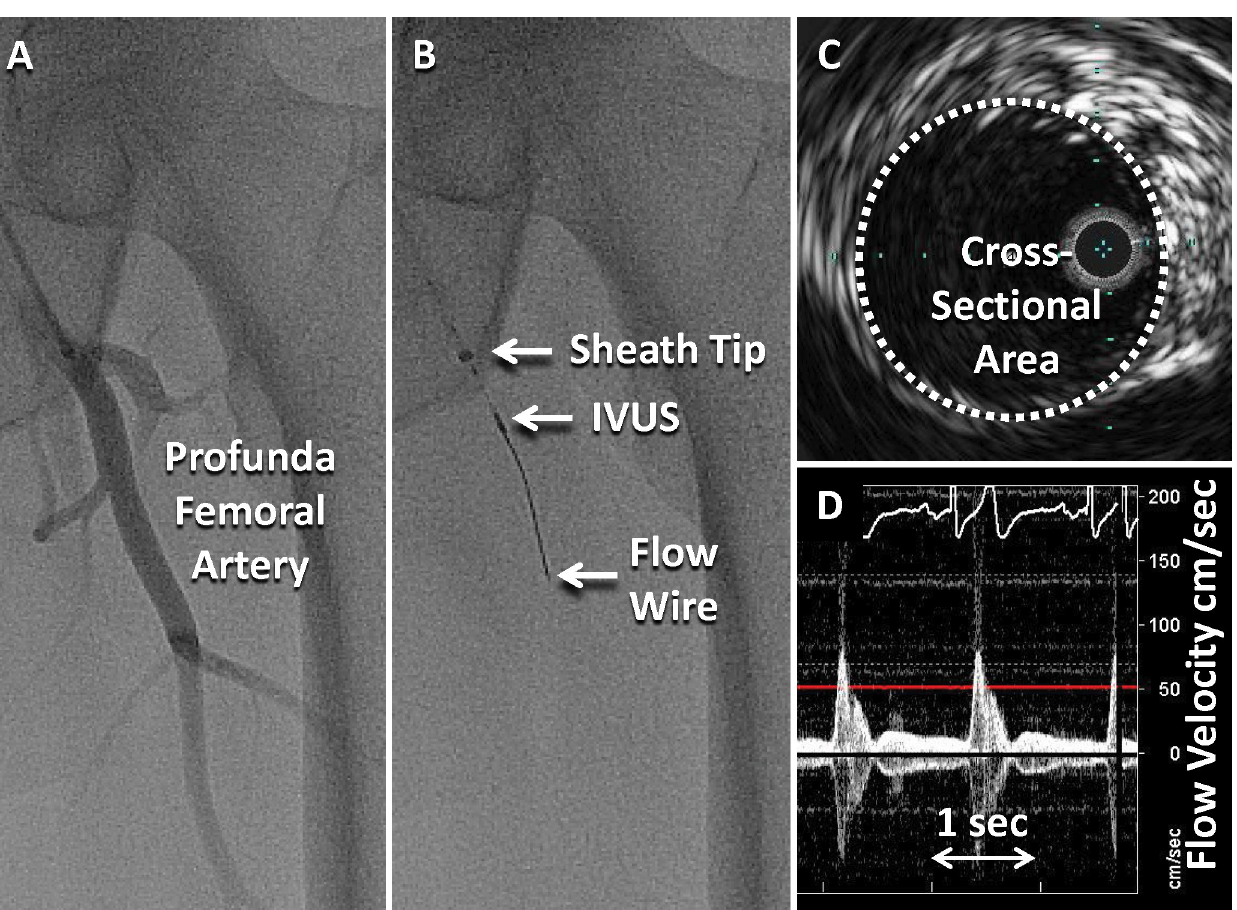
Fig 1. Catheter positions. A. Angiogram of the left profundal artery. B. Fluoroscopy showing the tip of the sheath, the intravascular ultrasound (IVUS) catheter, and the Doppler Flow wire. C. IVUS image showing the measurement of the cross-sectional area. D. Flow velocity integral used to estimate blood flow